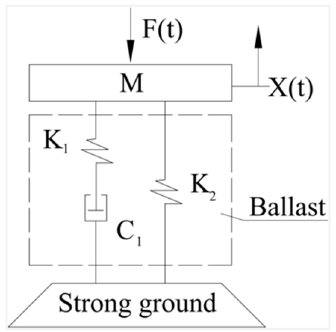
Figure 10. The state dependent model.